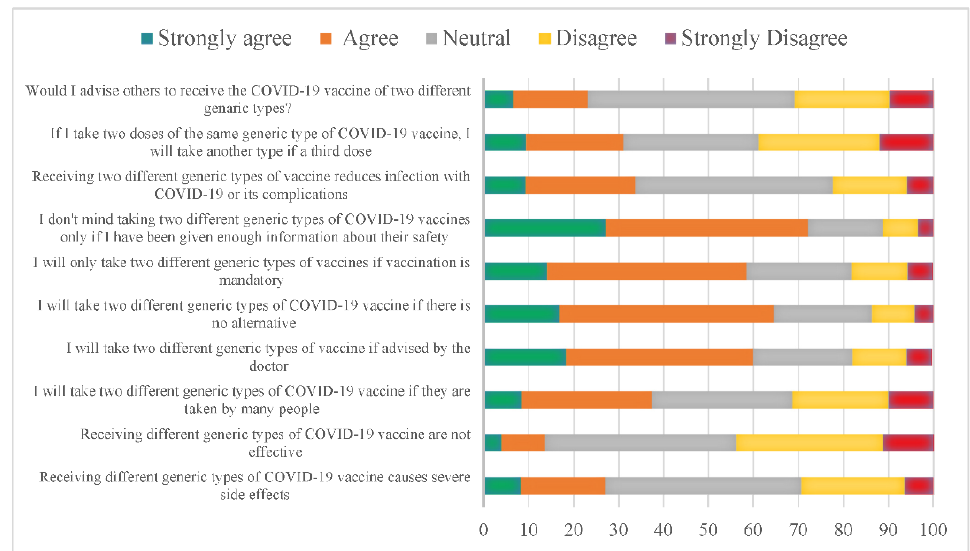
Figure 1. Perception of using various generic types of COVID-19 vaccines , the “mix -and- match” strategy, in Saudi Arabia. The X axis represents the percentage of the participants.